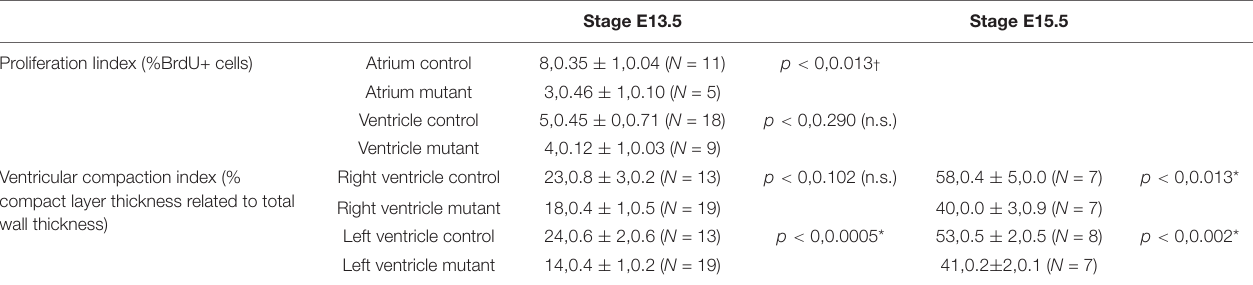
TABLE 3 | Proliferation index (% of BrdU+ nuclei) and ventricular compaction index (% compact layer thickness related to total wall thickness) in conditional WT1 mutant and control mice (stages E13.5 and E15.5).